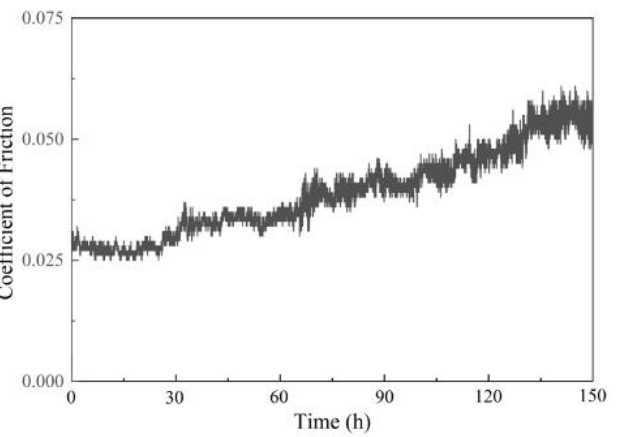
Figure 4. The coefficient of friction between the copper-steel tribo-pair under the lubrication of LCG grease as the function of wear time.